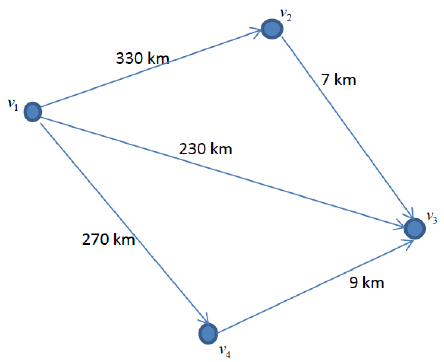
v —Klaipeda container terminal; Figure 4. Case study graph: 1 Figure 4. Case study graph: v 1 —Klaipeda container terminal; v 2 —Kaunas intermodal terminal; v 3 —Kaunas free economic zone; v 4 —inland waterway loading place.